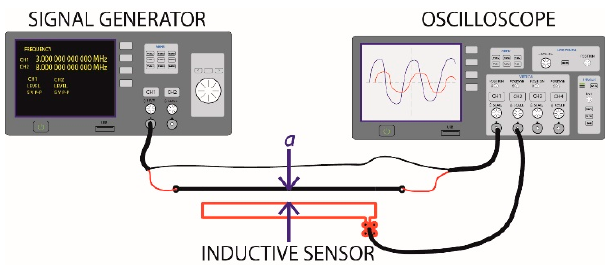
Figure 7. Experimental configuration for the characterization of M and the frequency response of the ILS.